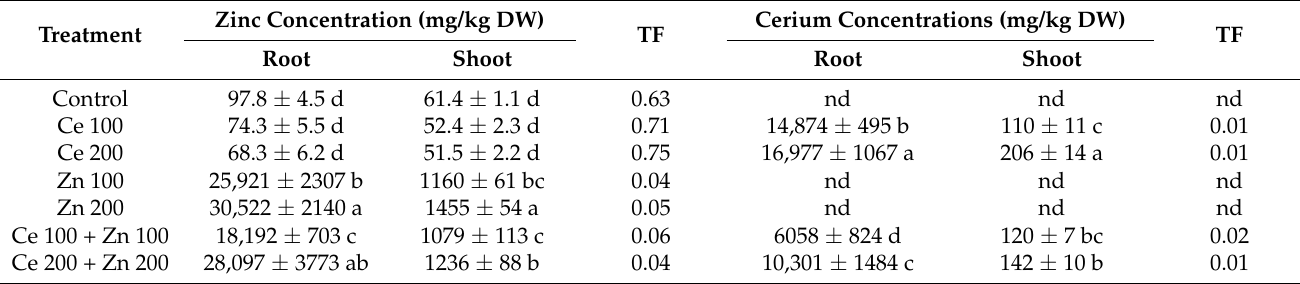
Table 1. Zinc and cerium concentrations in root and shoot of Pisum sativum L. grown under the sole or combined CeO 2 and ZnO NPs treatments accompanied by translocation factors (TF). Concentrations of nanoparticles are given in mg/L of elemental cerium or zinc, respectively. The cultivation time was 12 days. Data are the means ± SD ( n = 6). Distinct letters show the statistically significant differences among treatments as calculated with Tukey’s HSD post hoc test ( p = 0.95). nd: concentration below the detection limit (18 µ